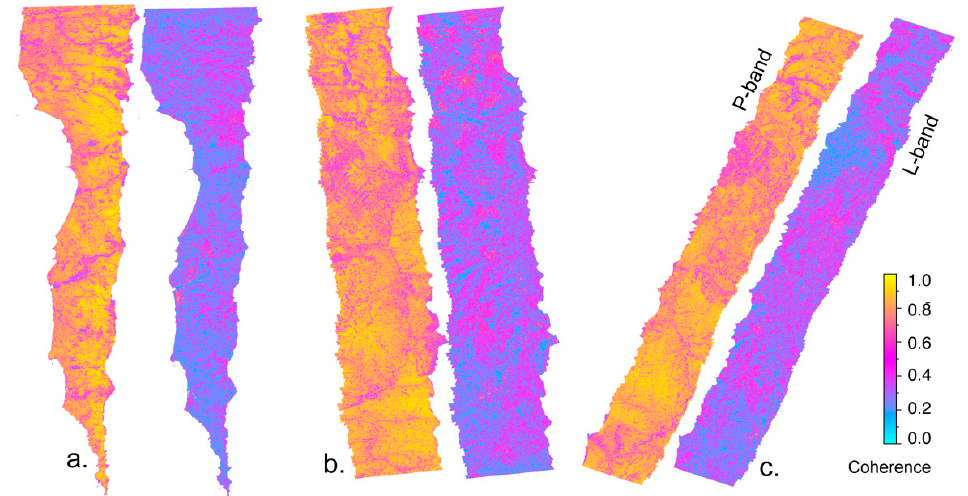
Figure 3. Comparison of coherence for L-band and P-band InSAR. ( a – c ) depict coherence maps of the P-band and L-band InSAR for the regions GB, SB, and HC, respectively. Multi-looking factors of 3 by 12 pixels (range by azimuth) were applied to both the P-band and L-band SAR data for the coherence estimations.